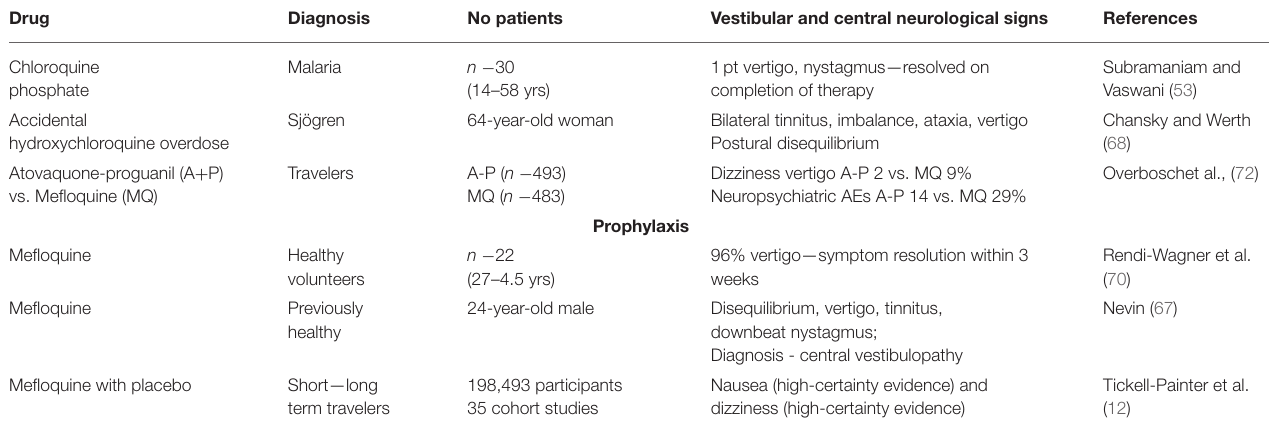
TABLE 4 | Drugs associated with vestibular